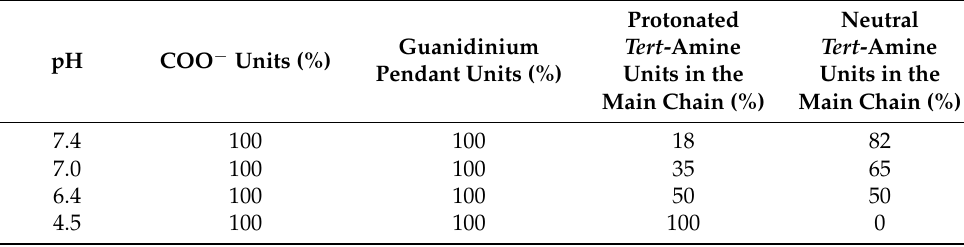
Table 1. pH-dependent ionic species distribution in the repeat units of P3 and P5 a .